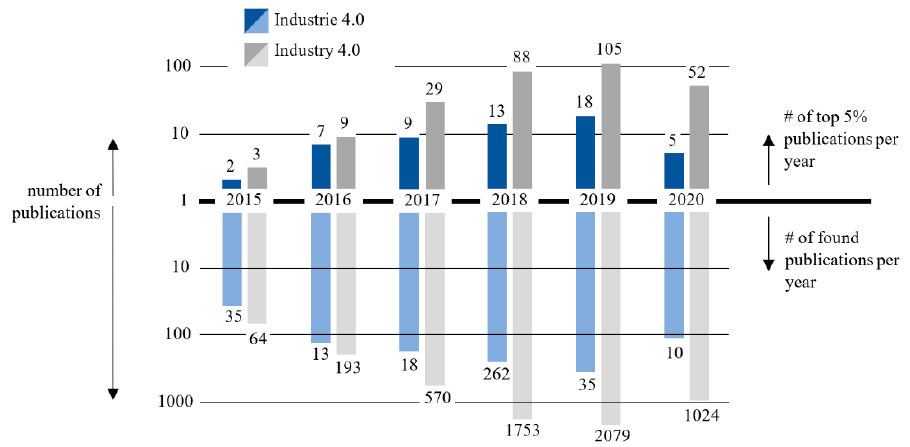
Figure 3. Relevant publications within the specifications for literature research and bibliometric analysis.